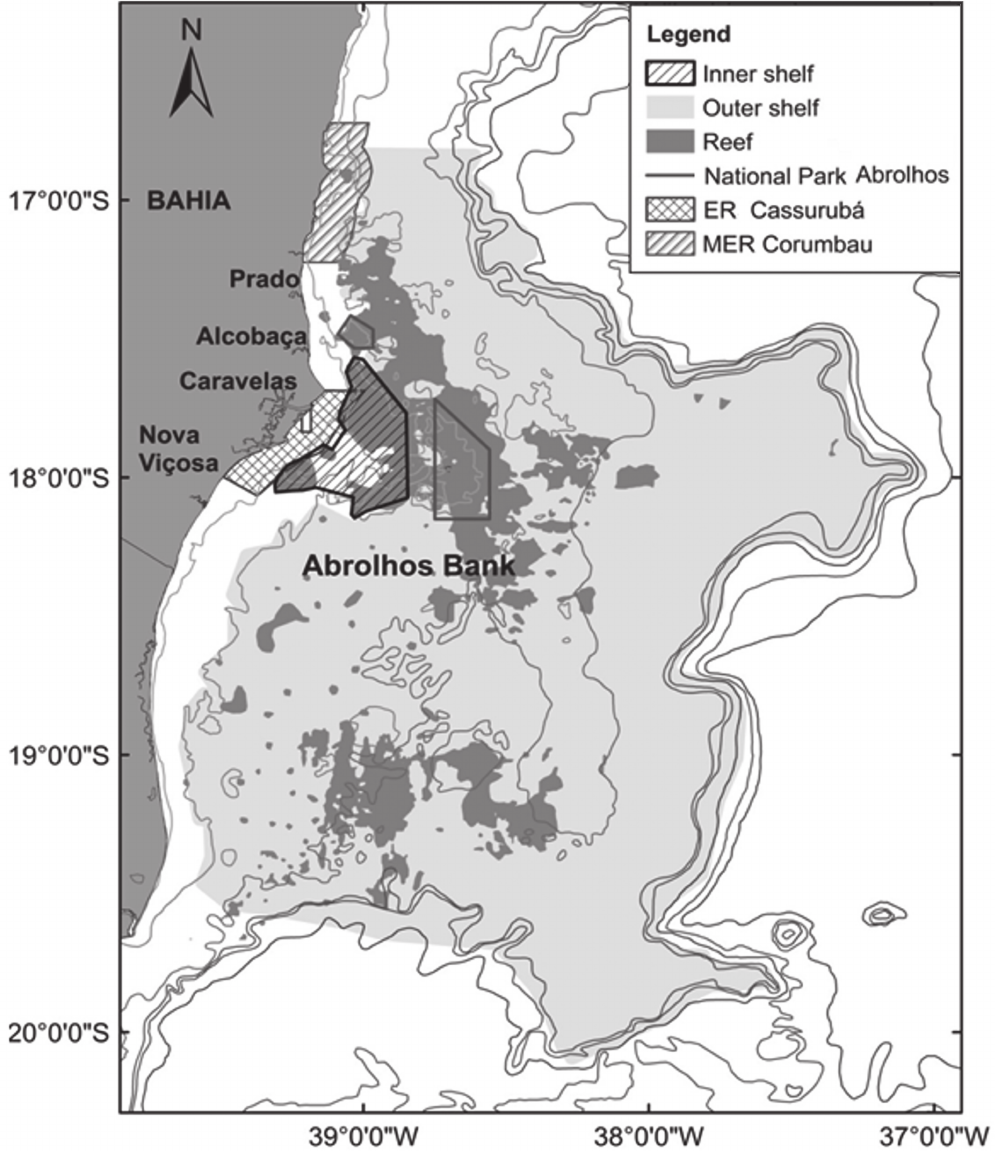
Fig. 1. Map of the Abrolhos Bank showing the municipalities where samples were collected and emerging coralline reefs are shown in dark grey. MER= Marine Extractive Reserve; ER= Extractive